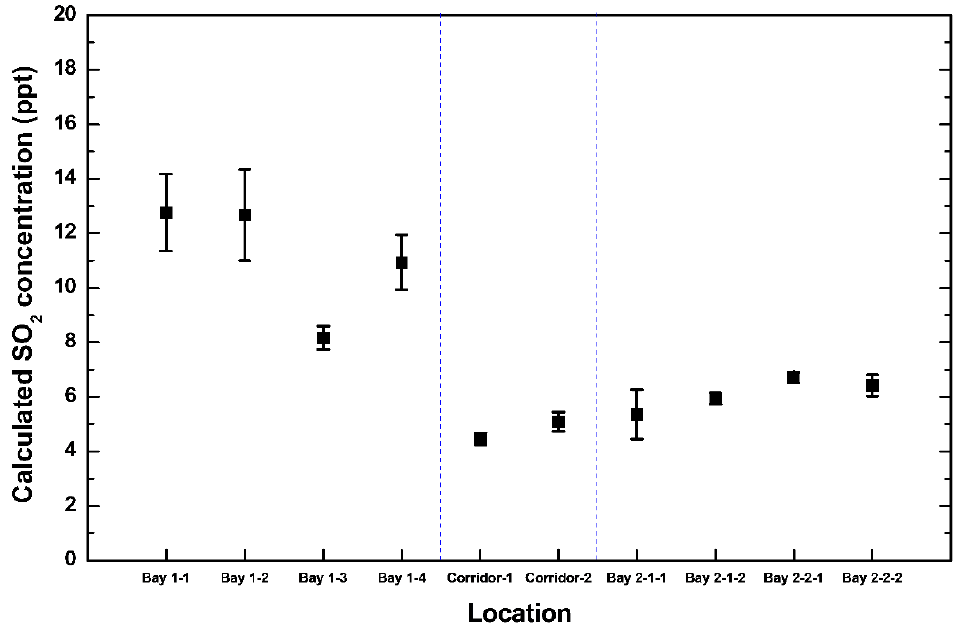
Figure 4. Equivalent SO 2 concentrations calculated from the total particle volume concentrations through 194 the calibration curve between SO 2 and the total particle volume concentrations. 195